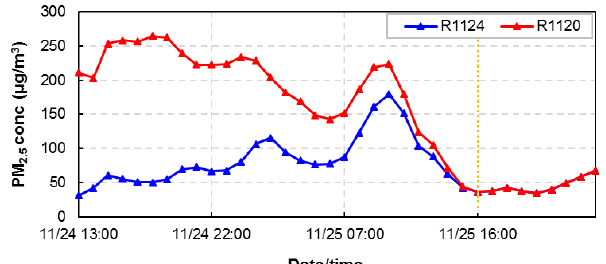
Figure 9. The time series of hourly simulated PM 2 . 5 concentrations using the restart files during a spin-up time period. The red and blue lines represent the R1120 and R1124 model sensitivity experiments respectively. The starting day of the model simulation for R1120 was 20 November 2016, and the starting day of the model simula- tion for R1124 was 24 November 2016.